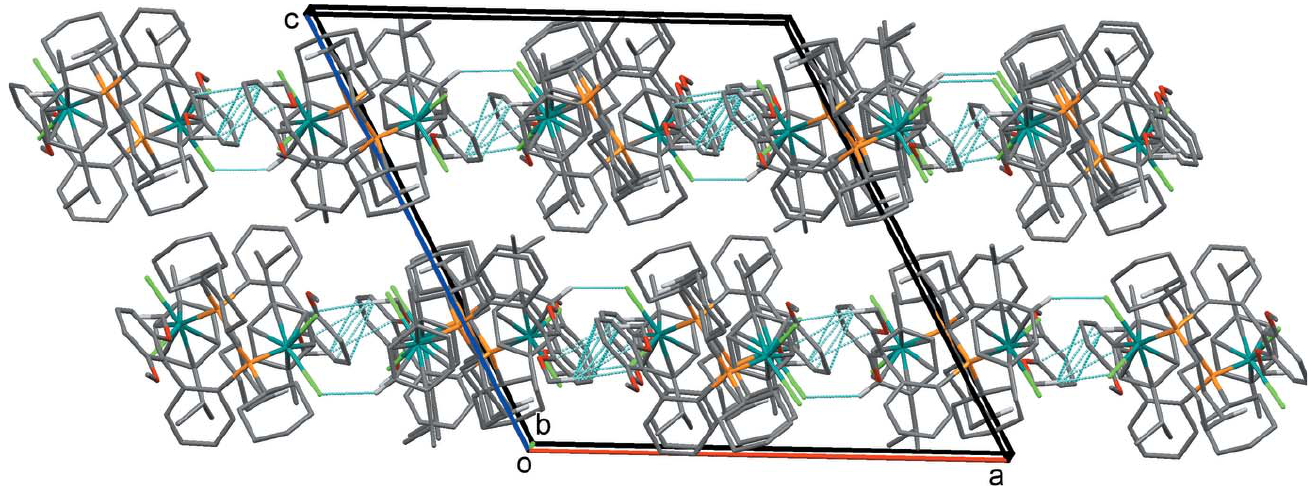
Figure 4 Aview along the b axis of the crystal packing of compound I . The intermolecular interactions are shown as dashed lines (see Table 1), and only those H atoms involved in these interactions have been